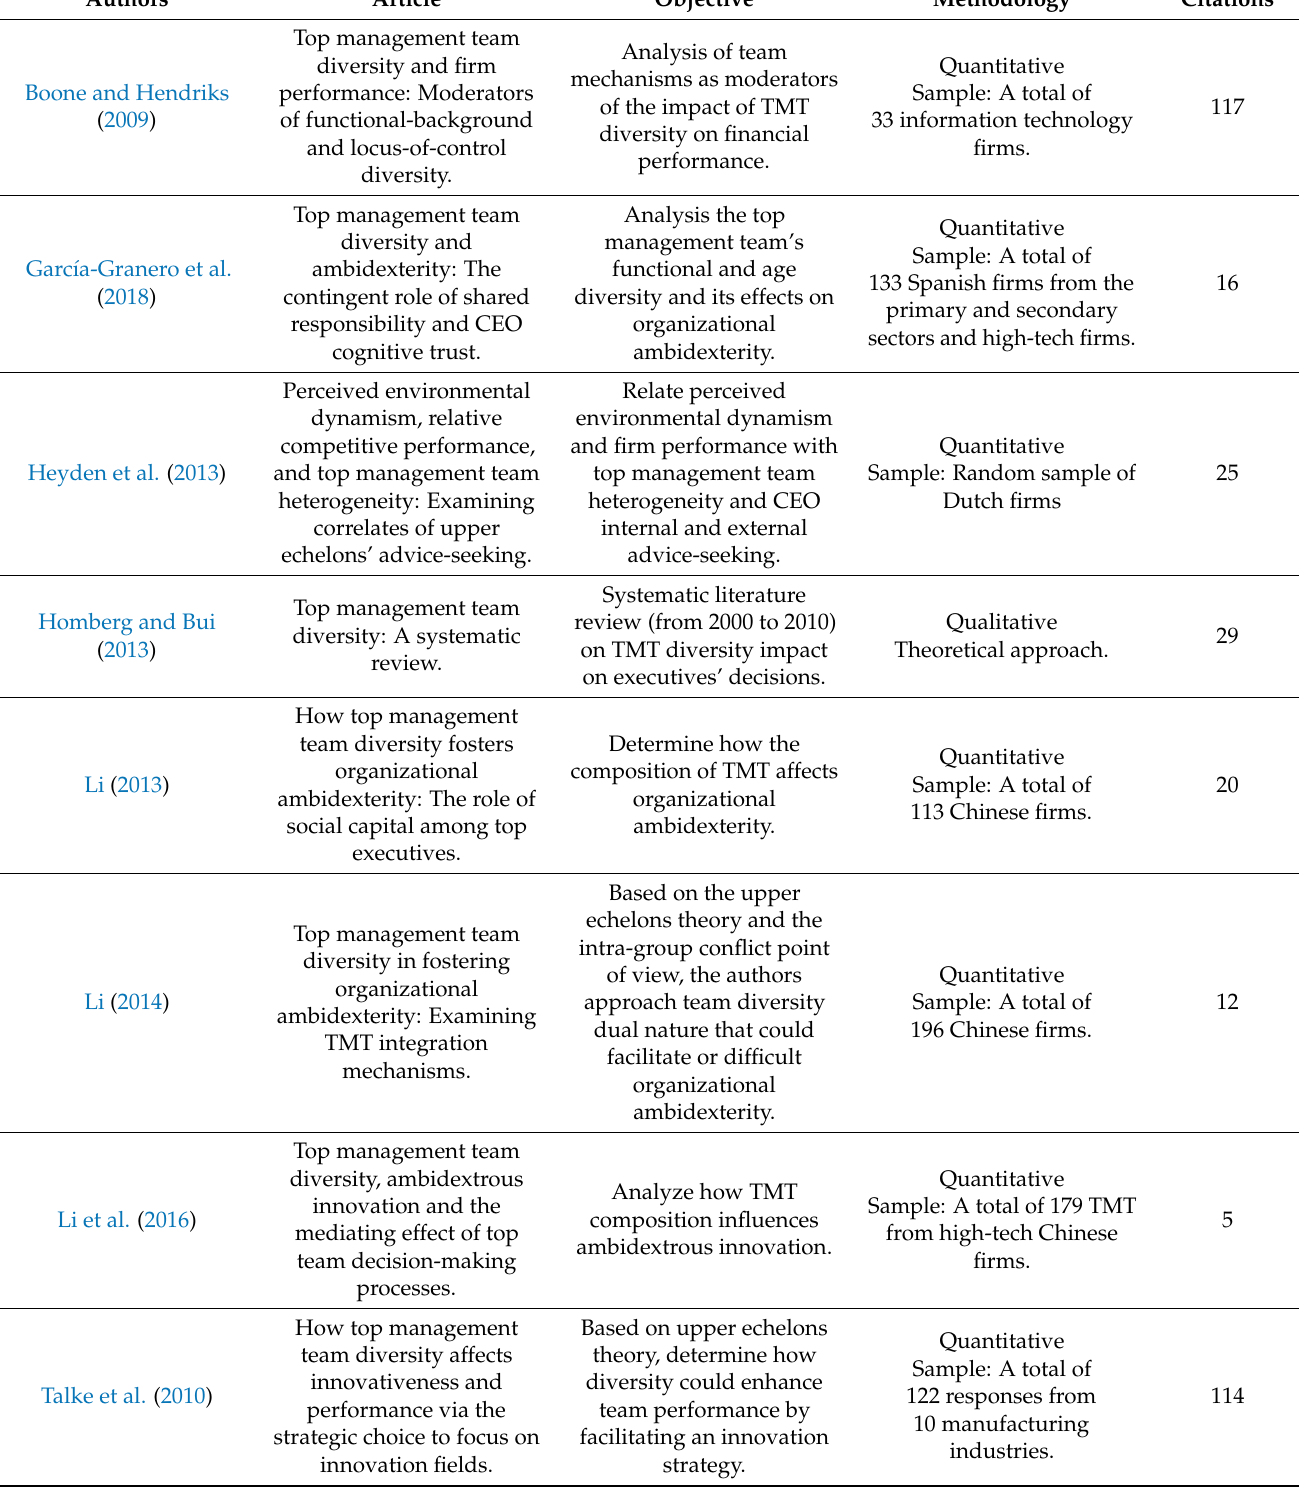
Table 6. Authors in Desirable Outcomes of